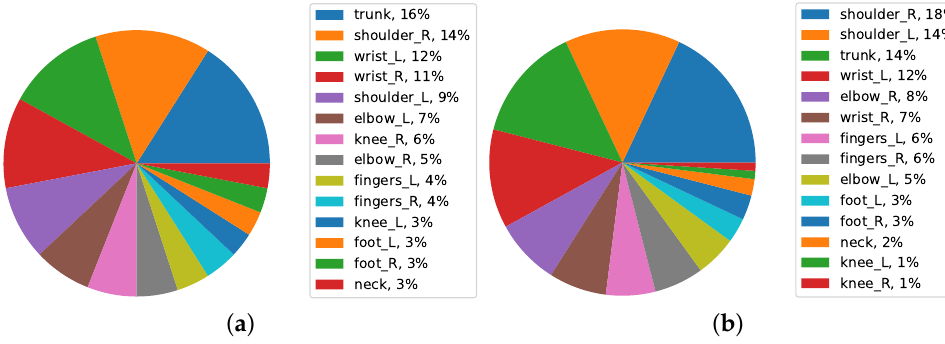
Figure 12. Average FWA of body parts in seniority of ( a ) 1–10 and ( b ) 10–20 data.